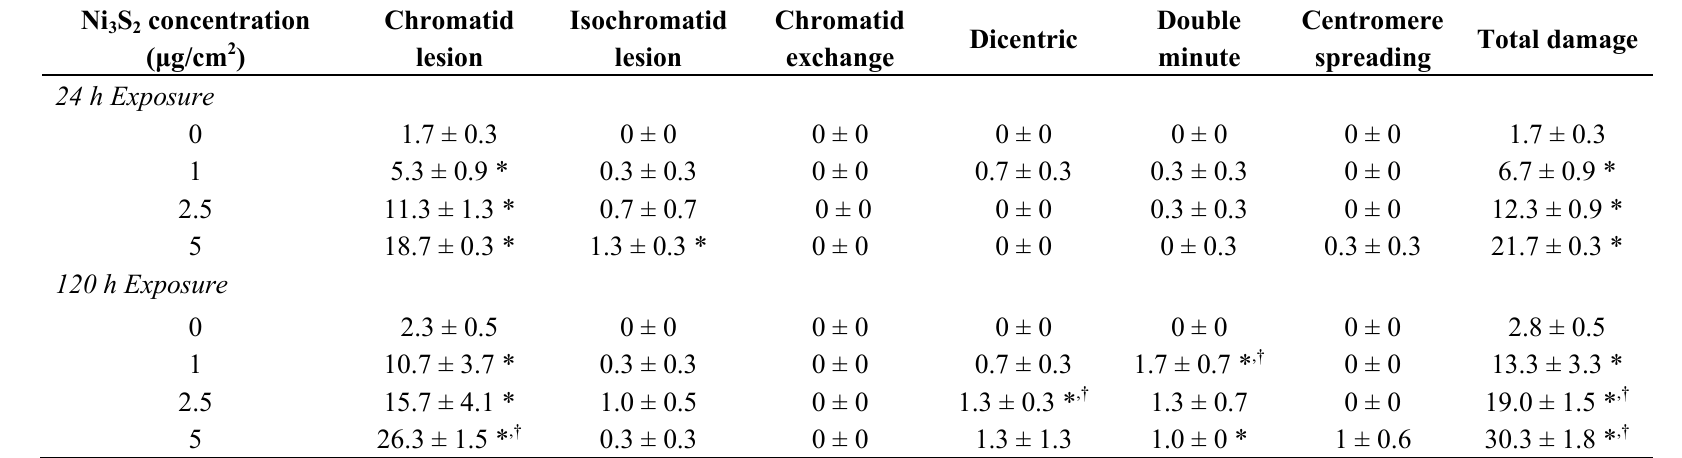
Table 1. Spectrum of chromosome aberrations induced by nickel subsulfide after 24 or 120 h